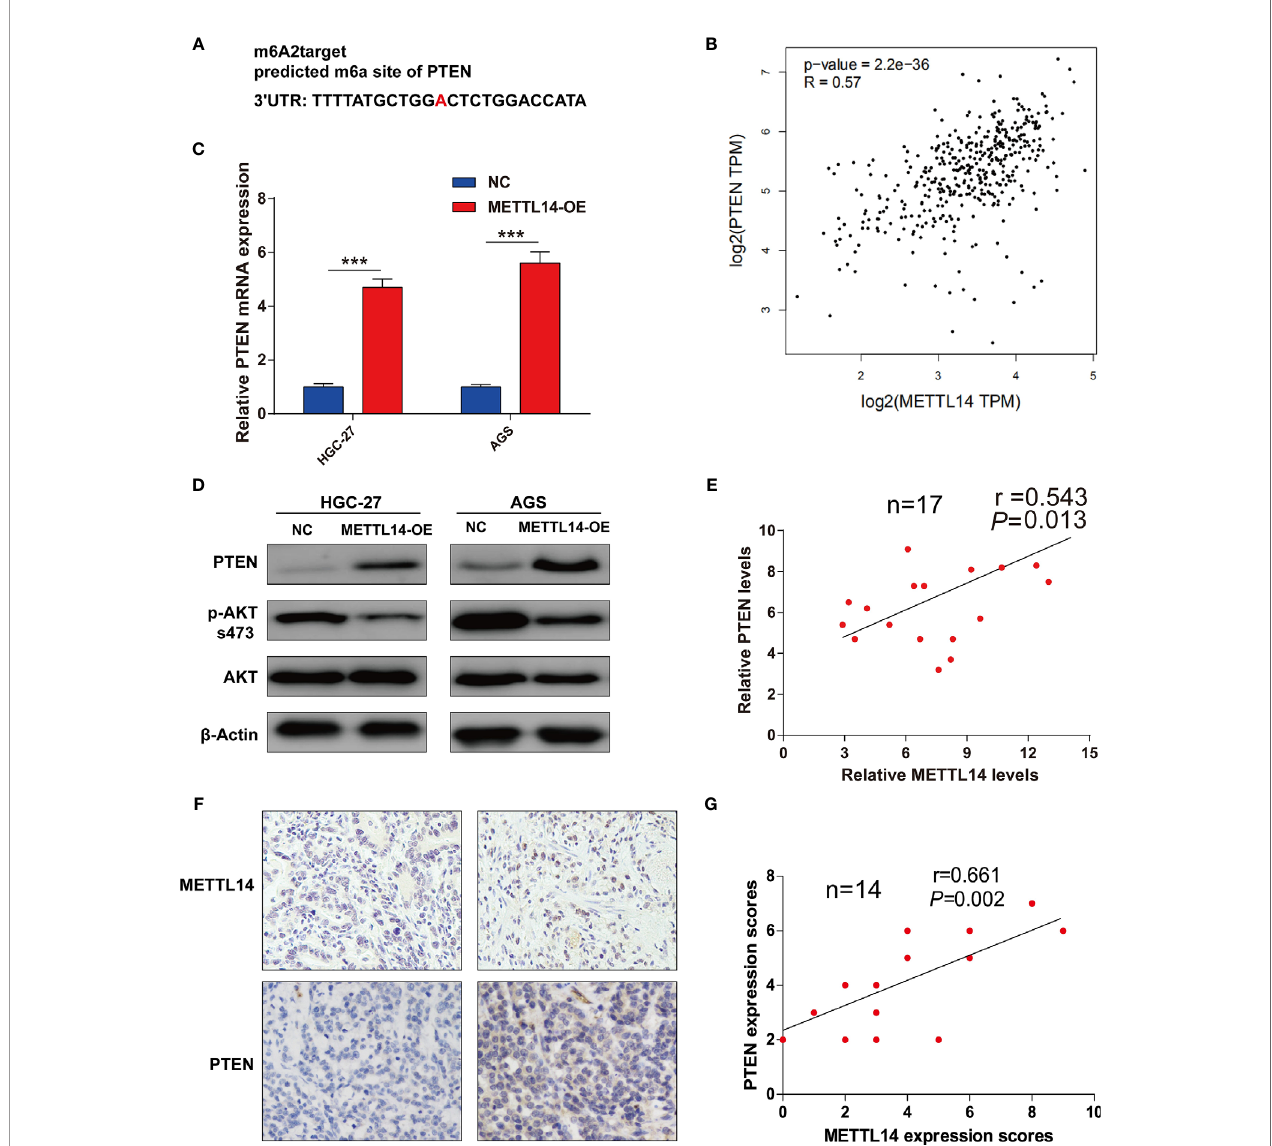
FIGURE 3 | METTL14 regulated PTEN expression in STAD. (A) The potential target site of PTEN modi fi ed by METTL14 was predicted by m6A2Target. (B) Correlation analysis between METTL14 and PTEN expression were performed by GEPIA database. (C) PTEN, AKT expression level, and AKT phosphorylation (Ser473) level were detected after METTL14 overexpression in HGC-27 and AGS cells (***P < 0.001). (D, E) Correlation analysis between METTL14 and PTEN mRNA expression in STAD tissue (n = 17); (F , G) Correlation analysis between METTL14 and PTEN protein expression in STAD tissue by IHC (n =